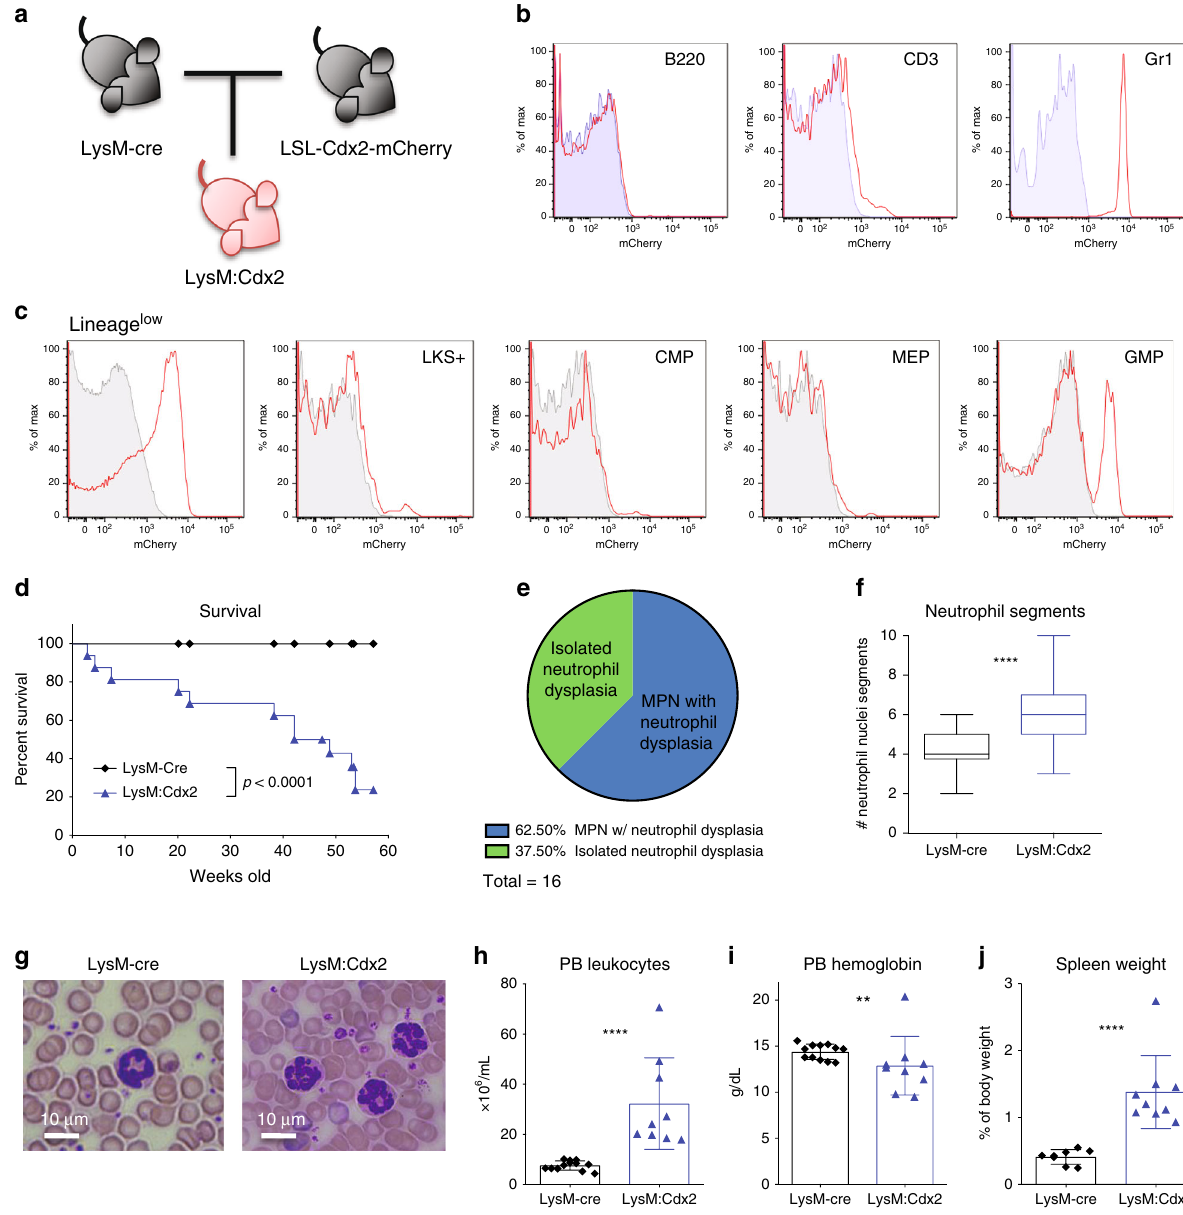
Fig. 4 Restricted myeloid expression of Cdx2 causes disease distinct from Scl:Cdx2. a Diagram of breeding strategy to product LysM:Cdx2 mice. LSL- Cdx2-mCherry mice are crossed with LysM -Cre knock-in mice at the endogenous LysM locus, leading to LysM-expressing GMP cells and their progeny to express Cdx2 and mCherry-reporter proteins. b Representative fl ow cytometry plots showing mCherry expression in PB subsets of LysM -Cre (blue shaded) and LysM:Cdx2 (red line) mice. c Representative fl ow cytometry plots showing mCherry expression in BM subsets of LysM -Cre (grey shaded) and LysM: Cdx2 (red line) mice. d Survival curve after 60 weeks of monitoring ( LysM -Cre, n = 23; LysM:Cdx2, n = 16). e Proportion of hematological state of LysM: Cdx2 mice at sacri fi ce. f Box plot of quanti fi cation of neutrophil nuclei segments in PB smears. Top and bottom of whiskers represent maximum and minimum values respectively, centre line within box represents median value, upper and lower quartiles represent 75th and 25th percentile respectively. At least 15 neutrophils were counted per slide by independent researchers, n = 4 per group. g Wright-Giemsa stained PB smears showing representative neutrophils of LysM -Cre and LysM:Cdx2 mice. Scale bars on bottom left of each image indicate 10 µ m. h PB leukocyte (WBC) and i hemoglobin levels of mice at sacri fi ce ( LysM -Cre n = 12; LysM:Cdx2 n = 9). j Spleen size relative to body mass of mice at sacri fi ce ( LysM -Cre n = 7; LysM:Cdx2 n = 9). N = biologically independent animals. Statistical analyses performed using two-tailed Mann – Whitney test. Data are plotted as mean values + / − SD. n.s.; not signi fi cant. ** P < 0.01, **** P <